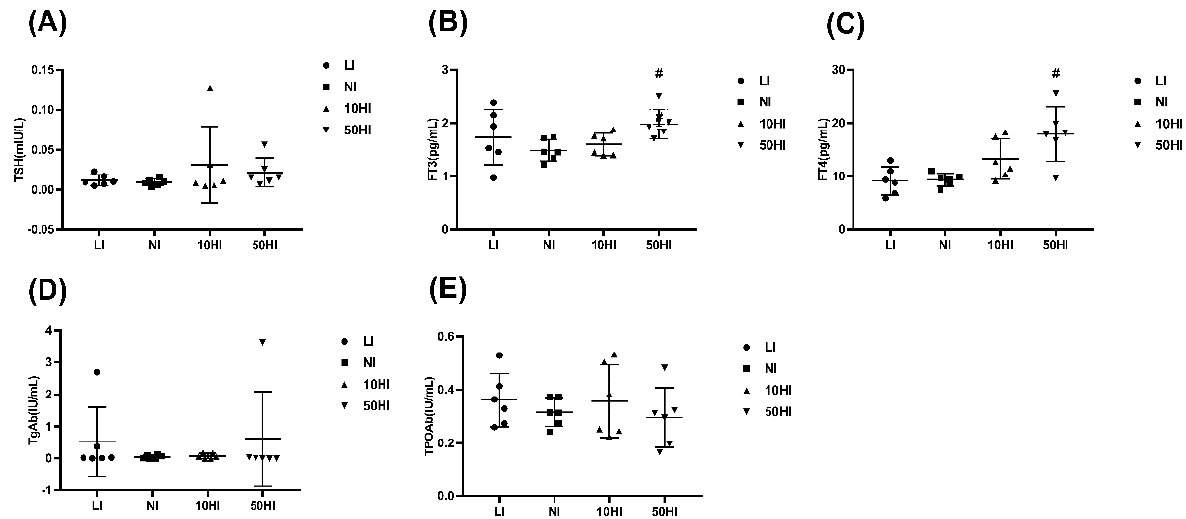
Serum total iodine concentration, STIC; Serum non-protein-bound iodine concentration, SNBIC; Urinary iodine concentration, UIC. # p < 0.05 compared with the NI group. a The urinary iodine concentration was the average value over two days.